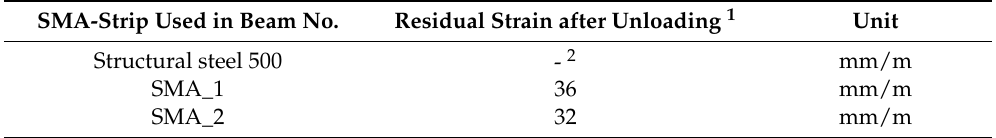
Table 4. Residuals strain in the SMA after prestraining and unloading.